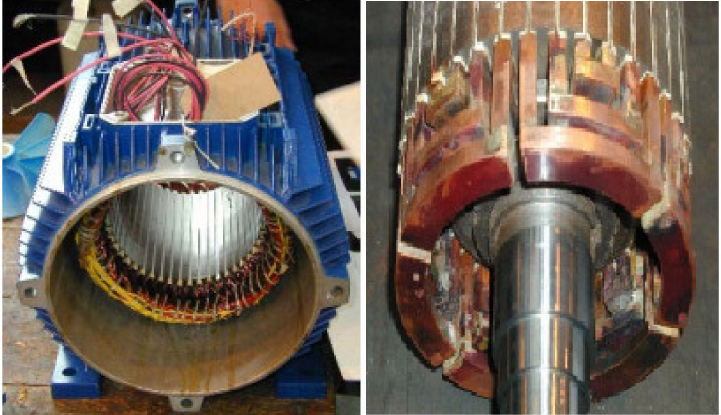
Figure A2. Single frame implementation using two windings in stator and nested rotor